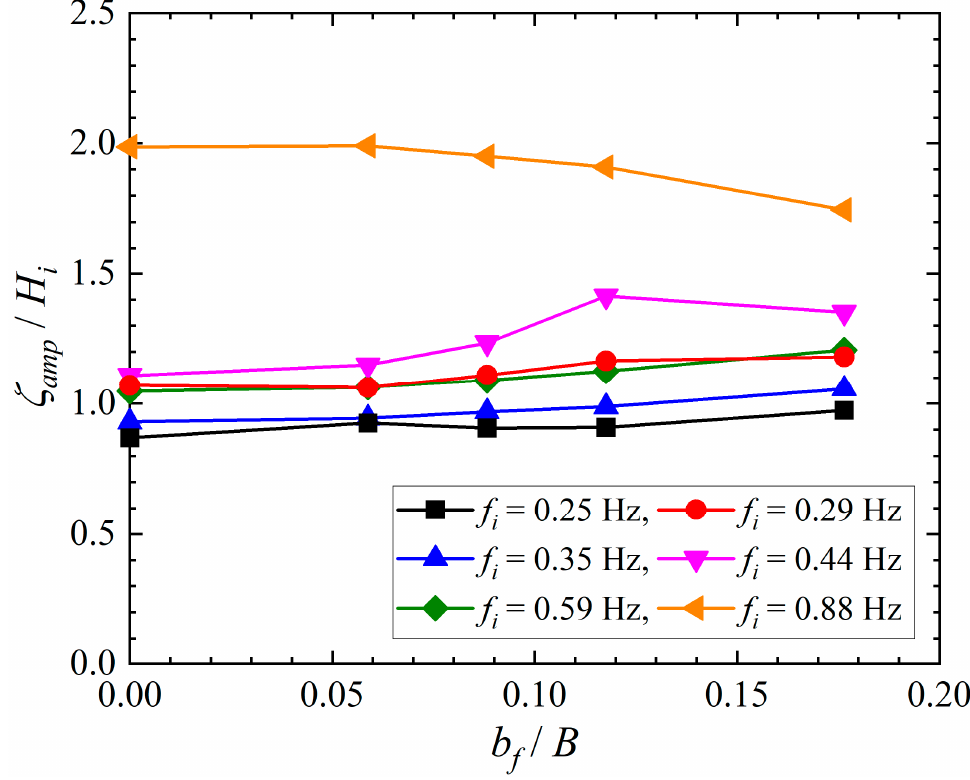
Figure 6. Relationship between ζ amp / H i and b f / B for the heave motion.